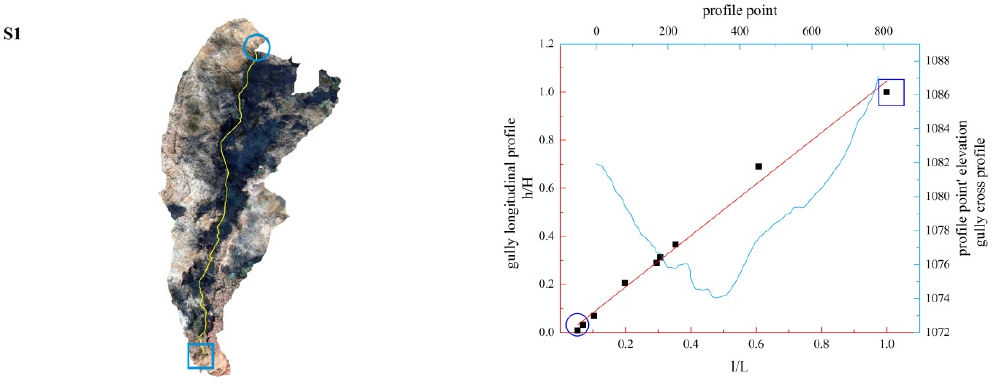
Figure 14. Gully shape and profile fitting diagram of S1.